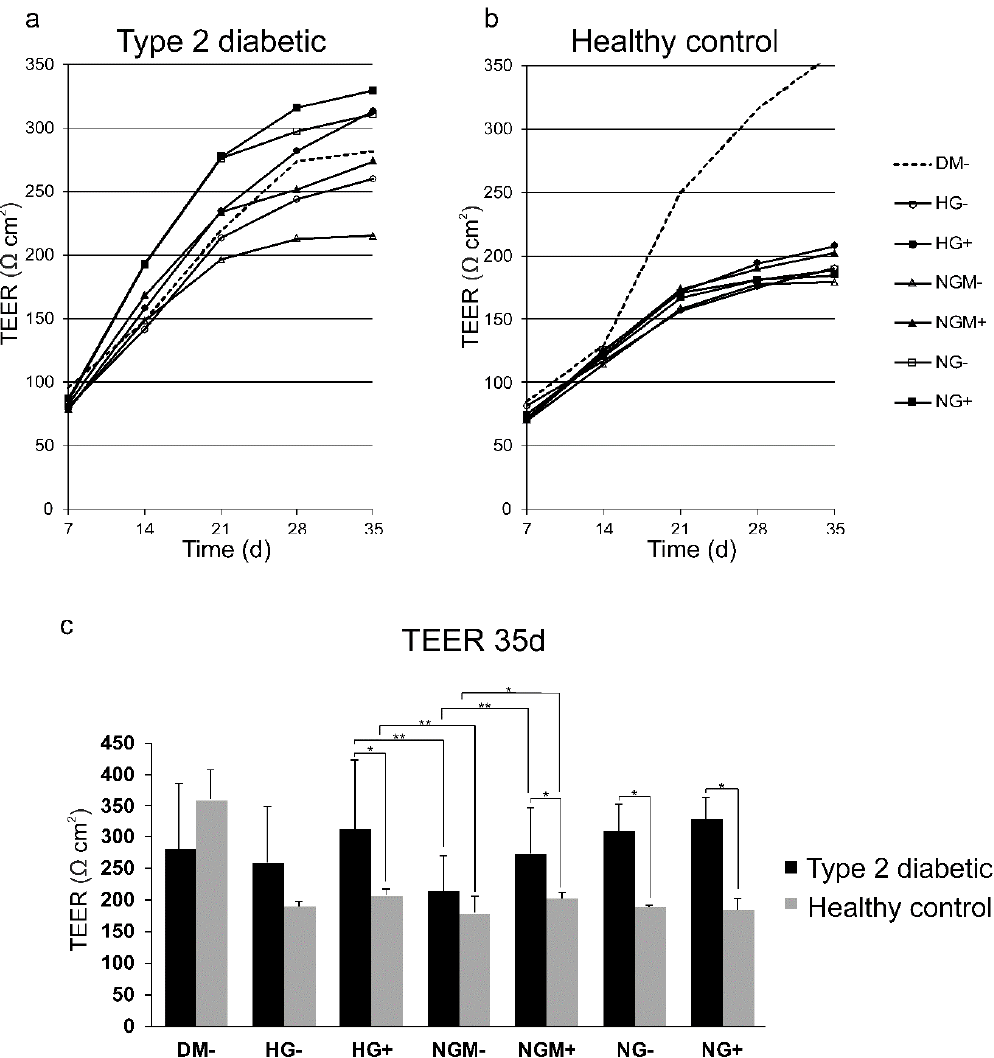
Figure 4. Development of barrier function in diabetic and healthy control hiPSC-RPEs. Cells were cultured for 5 weeks in different glucose and insulin concentrations (see treatments and abbreviations below). The development of trans-epithelial electrical resistance (TEER) during the five-weeks culture: ( a ) represents three type 2 diabetic cell lines (UTA.08002.DMs, UTA.08203.DMs, UTA.10802.EURCCs) ( n = 3–4 biological, and 2 technical replicates); ( b ) represents one healthy control cell line (UTA.10902.EURCCs) ( n = 3 biological, and 2 technical replicates). ( c ) The TEER after 35 days of culture. Data are presented as mean ± SD. Statistical significance * p < 0.05, ** p < 0.01. HG represents high glucose (25 mM); NG represents normal glucose (5 mM); NGM represents normal glucose (5 mM) balanced with mannitol (19.5 mM). DM − is the control culture medium, which is ordinarily used for hiPSC maturation.